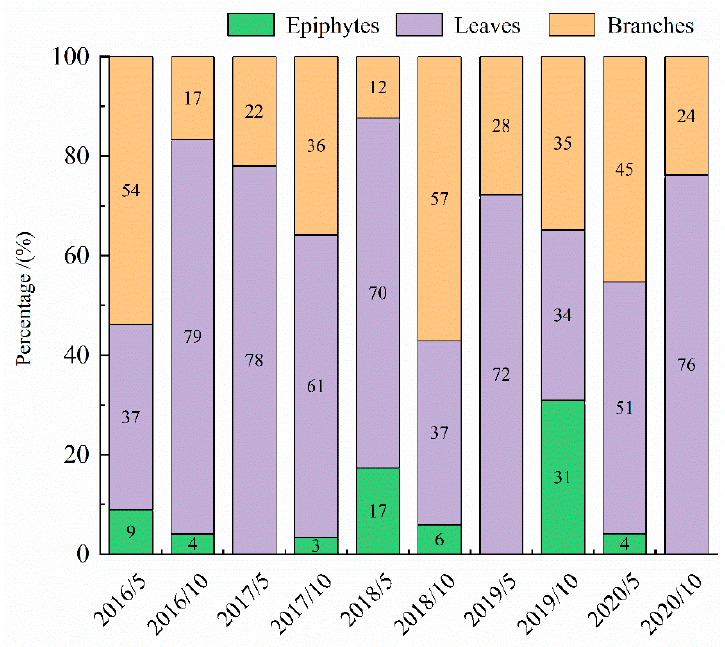
Figure 5. Proportions and production of each litter component from 2016 to 2020 in the A. faxoniana forest. The values represent the means ± SD; n = 45.